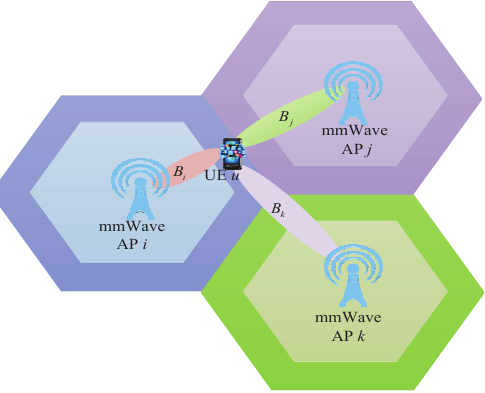
Figure 5. The best beam and the strongest interference beams of the edge user equipment